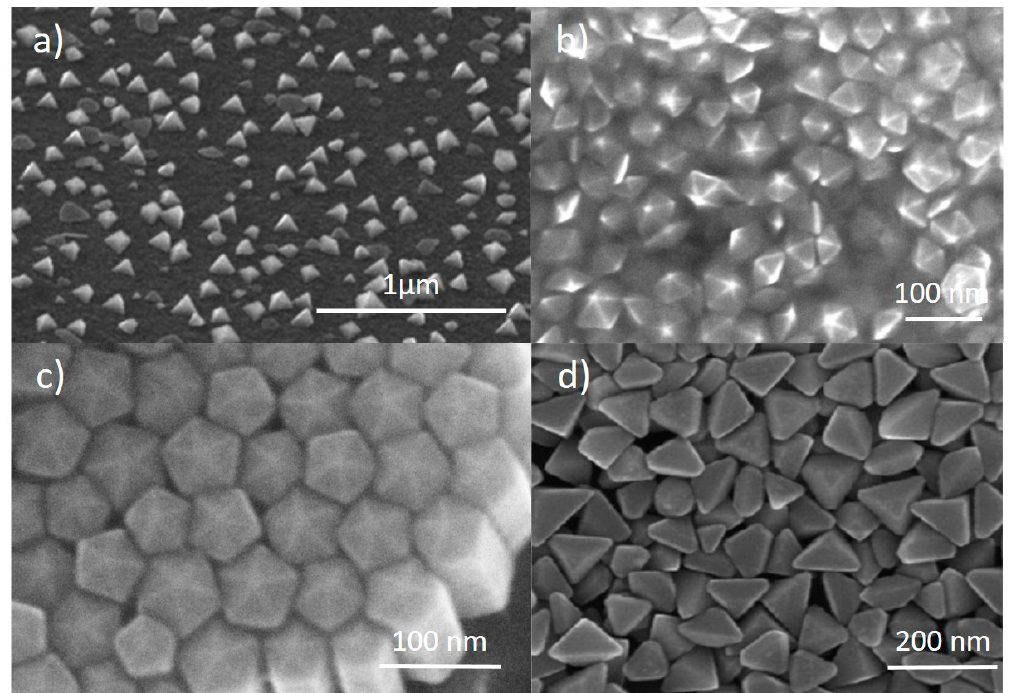
Figure 8. SEM images from: ( a ) Ag nano tetrahedra. Reprinted with permission from ref. [38] . Copyright (2008) American Chemical Society. ( b ) Ag nanodecahedra. Reprinted with permission from ref. [39] . Copyright (2008) American Chemical Society. ( c ) Ag pentagonal nanorods. Reprinted with permission from ref. [40] . Copyright (2009) American Chemical Society. ( d ) Ag nanobipyramids. Reprinted with permission from ref. [43] . Copyright 2010 American Chemical Society.